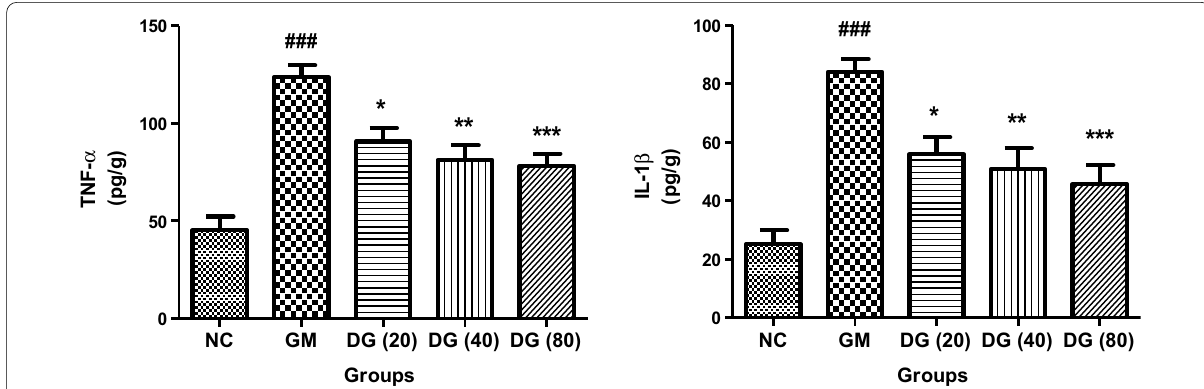
Fig. 7 Effect of DG on TNF-α and IL-1β (pg/g) in GM induced renal damage in rats. Values expressed as Mean compared to NC rats and * p < 0.05, ** p < 0.01, *** p < 0.001 as compared to GM